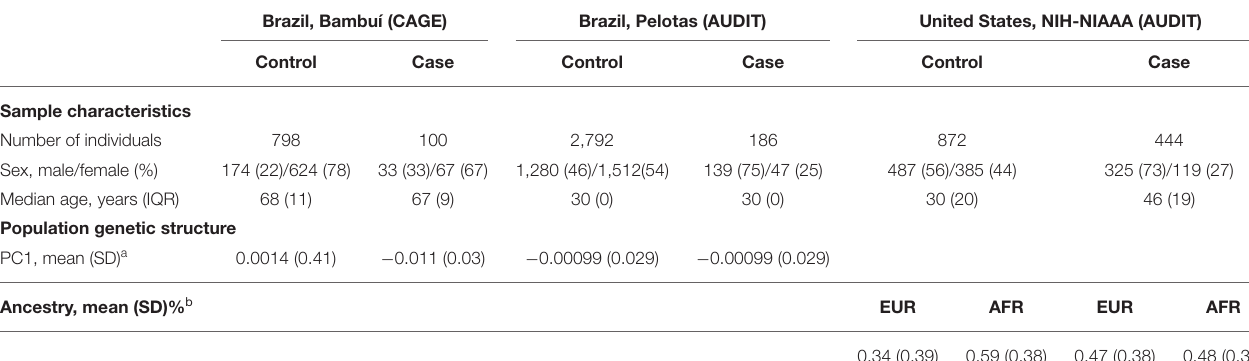
TABLE 1 | Characteristics of the studied populations (after quality control). Brazil, Bambuí